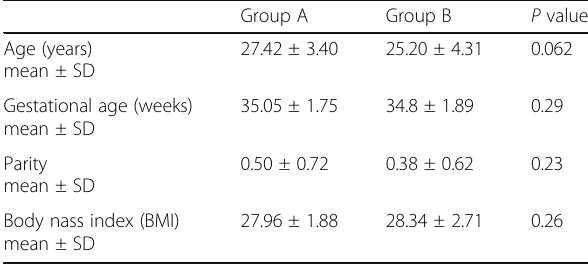
Table 1 Patients ’ criteria in groups A and